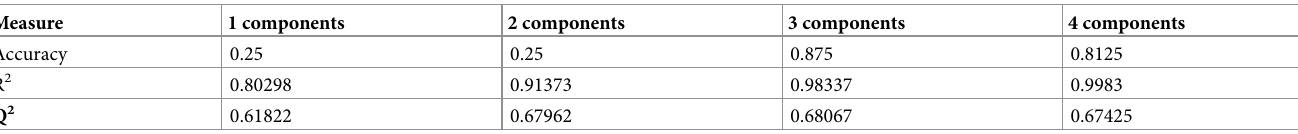
Table 1. PLS-DA cross-validation results based on Q 2